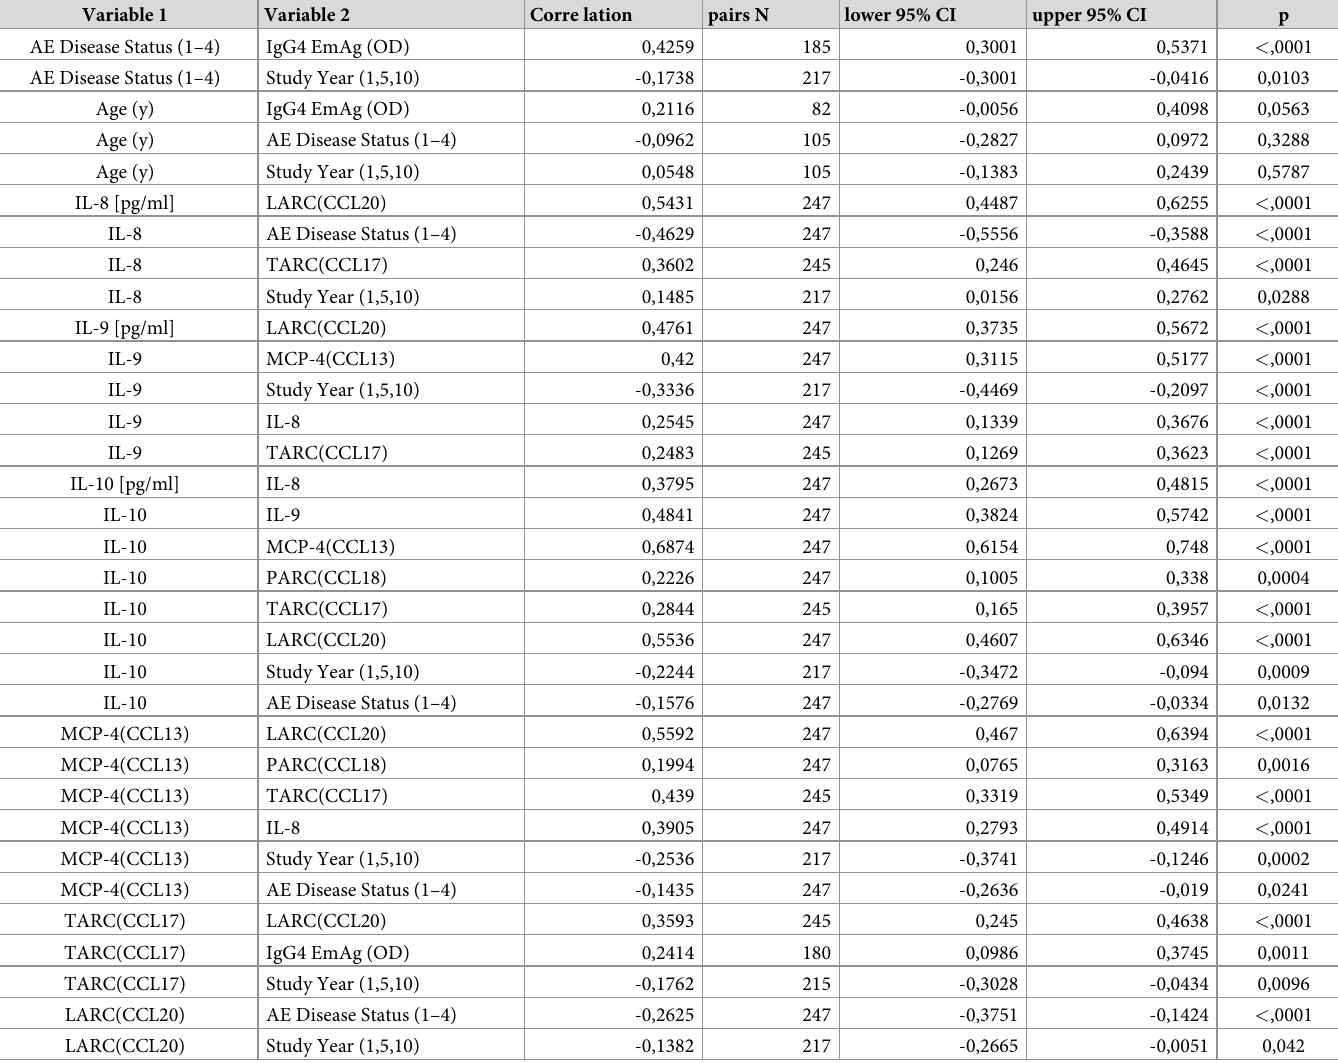
Table 9. Paired Correlations of serum levels of cytokines and chemokines (in pg/ml) in AE patients, with age (in years), EmAg-specific IgG4 responses (OD values), stage of AE disease (4:progressive, 3:stable, 2:cured; 1:control) (study groups: n = 217 AE patients, n = 30 infection-free controls) and year of sample collection (year 1, 5, 10) are